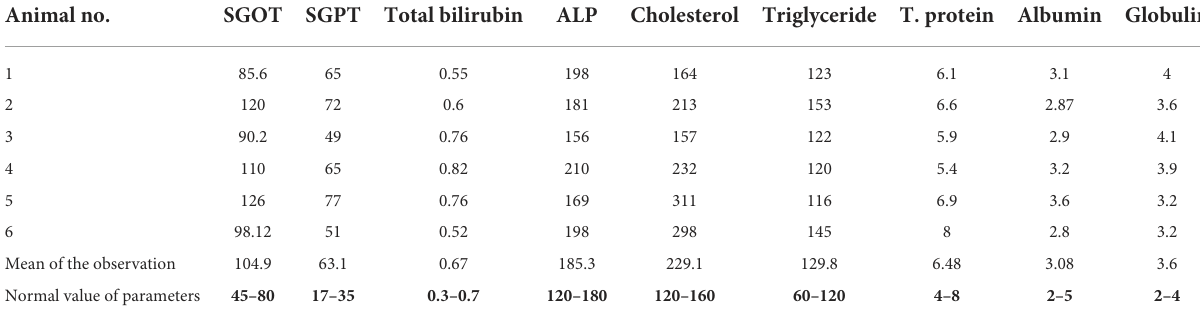
TABLE 6 Results of biochemical parameters of six rats after induction of hepatotoxicity. Animal